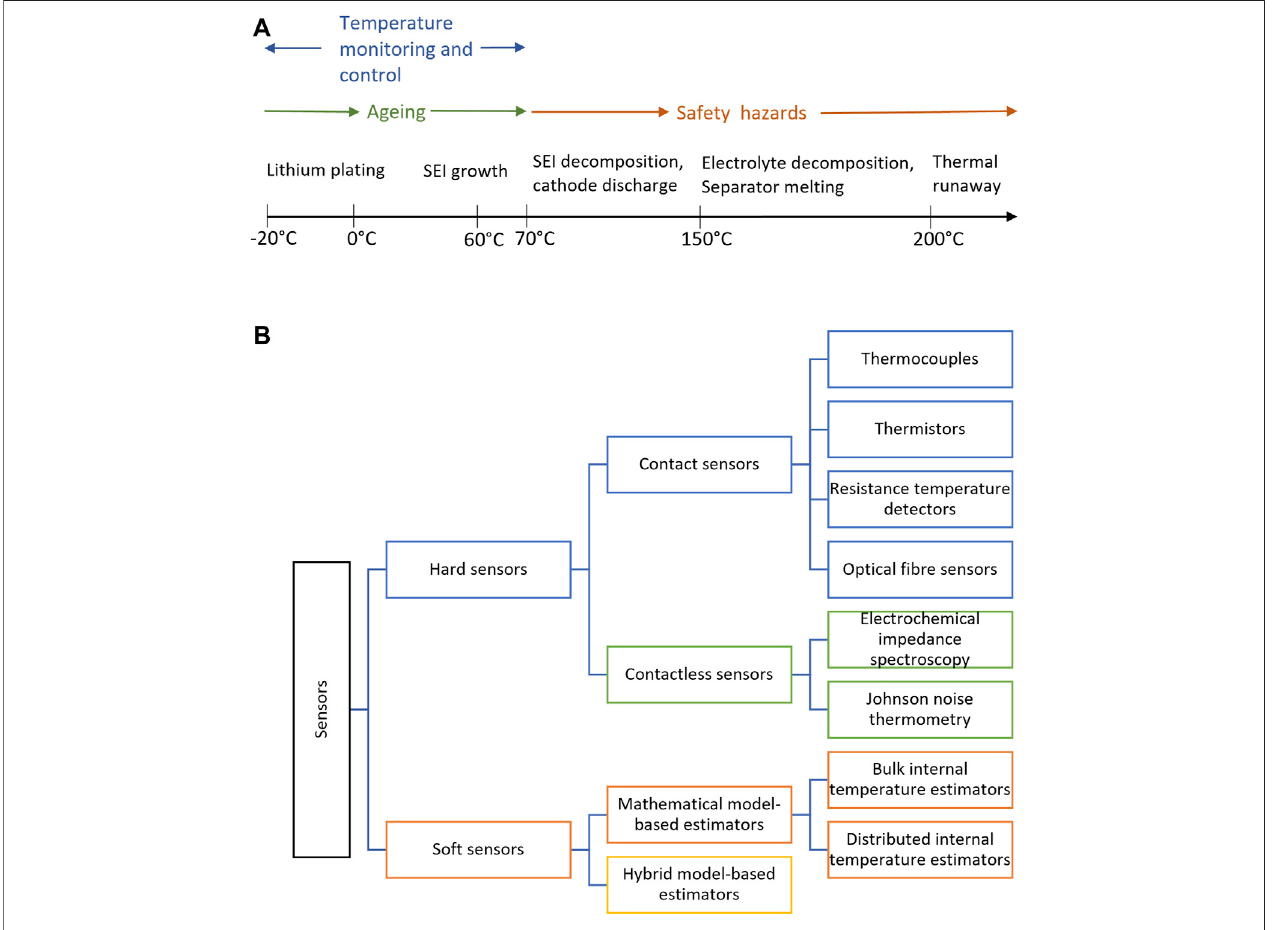
FIGURE 1 | (A) The in fl uence of temperature on the battery and the importance of temperature control. (not to scale) (B) Categorization of various sensor types.